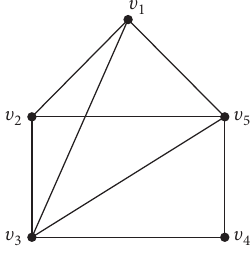
Figure 1: A graph with five